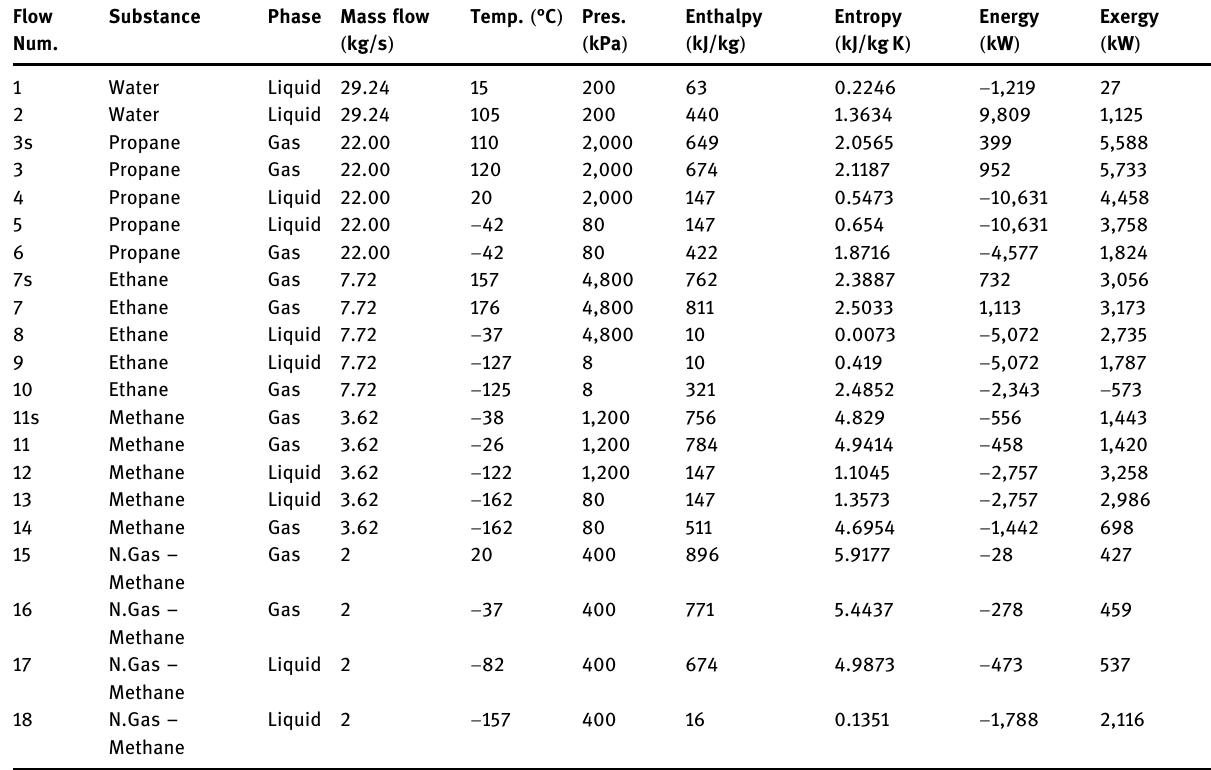
Table 8: Thermodynamic properties of fl ow lines for natural gas entering at 20°C and 400 kPa ( P 11 = 1,200 kPa )